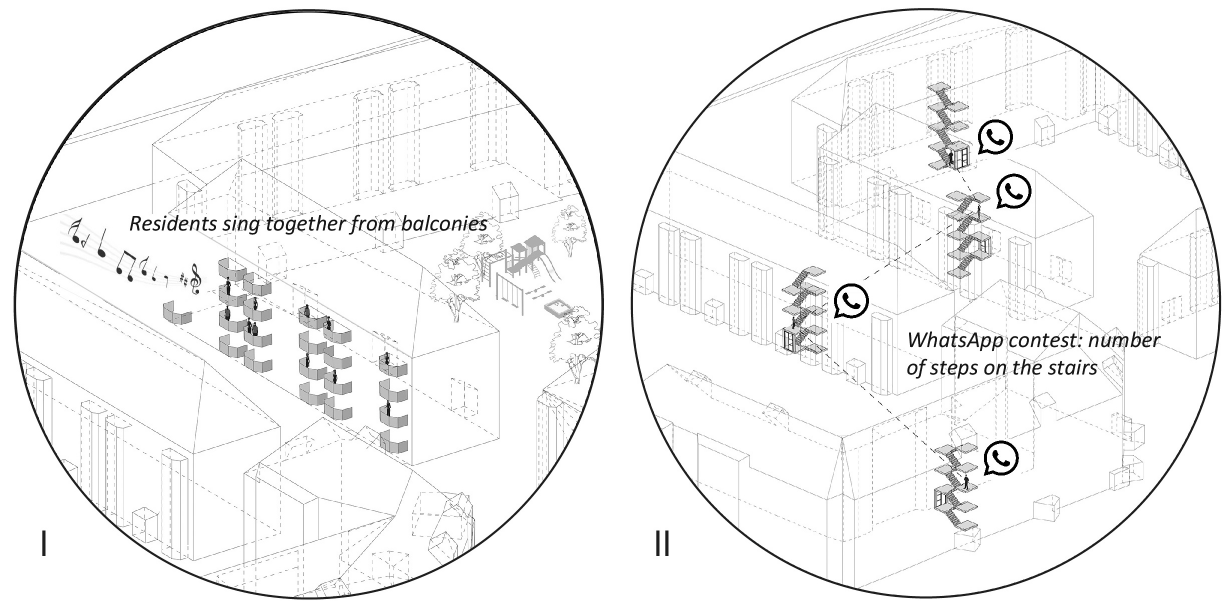
Figure 6. Informal social infrastructure (I) and non‐physical platforms (II) in Mjølnerparken. Urban Planning, 2022, Volume 7, Issue 4, Pages